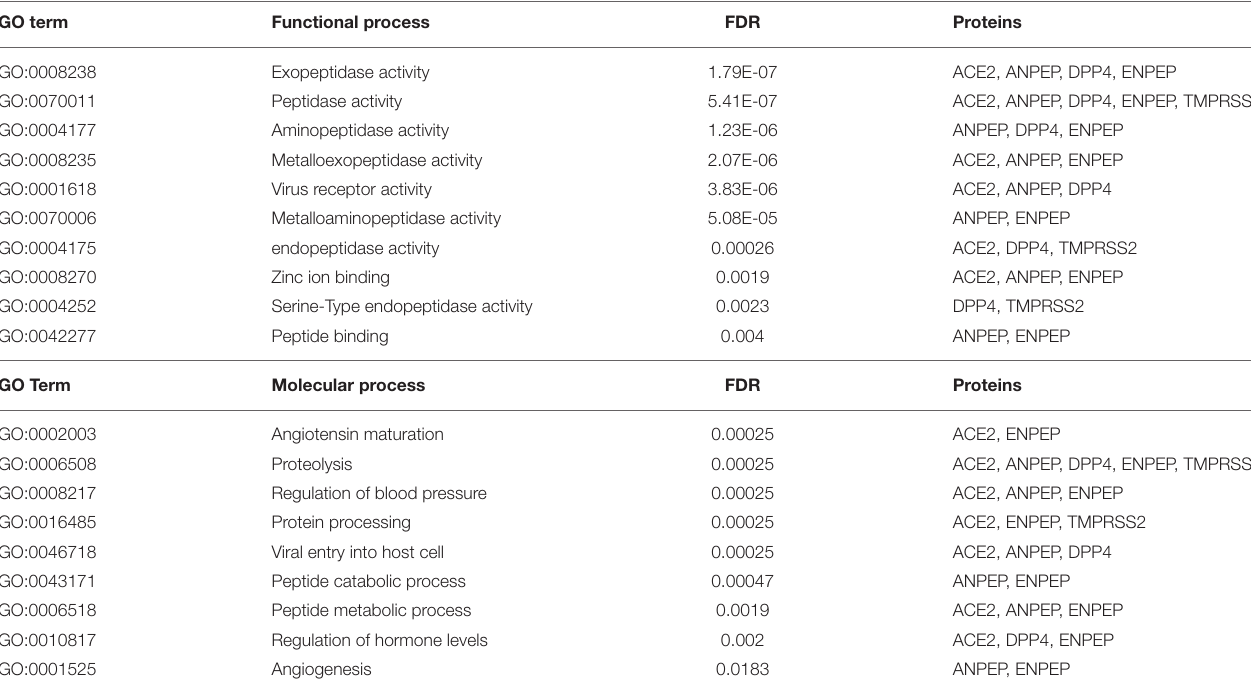
TABLE 1 | Functional and molecular process related to coronavirus